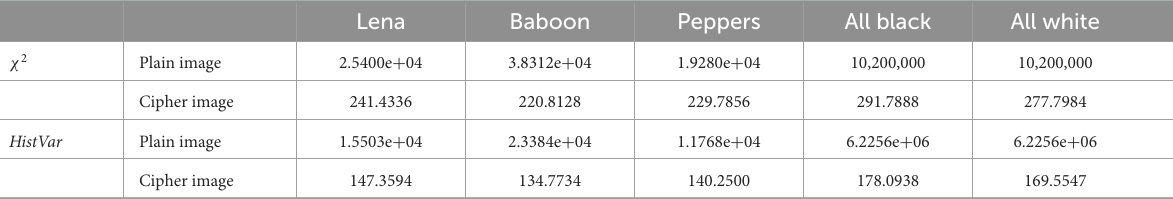
TABLE 5 χ 2 and histogram variance for the plain and cipher images.